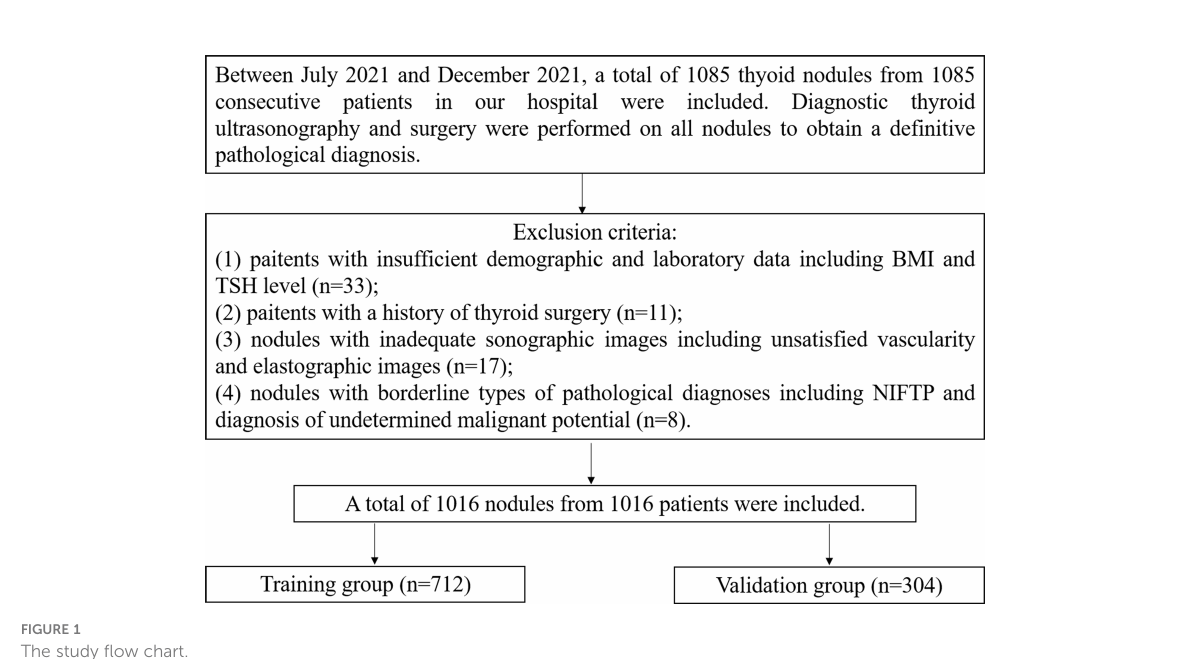
FIGURE 1 The study fl ow